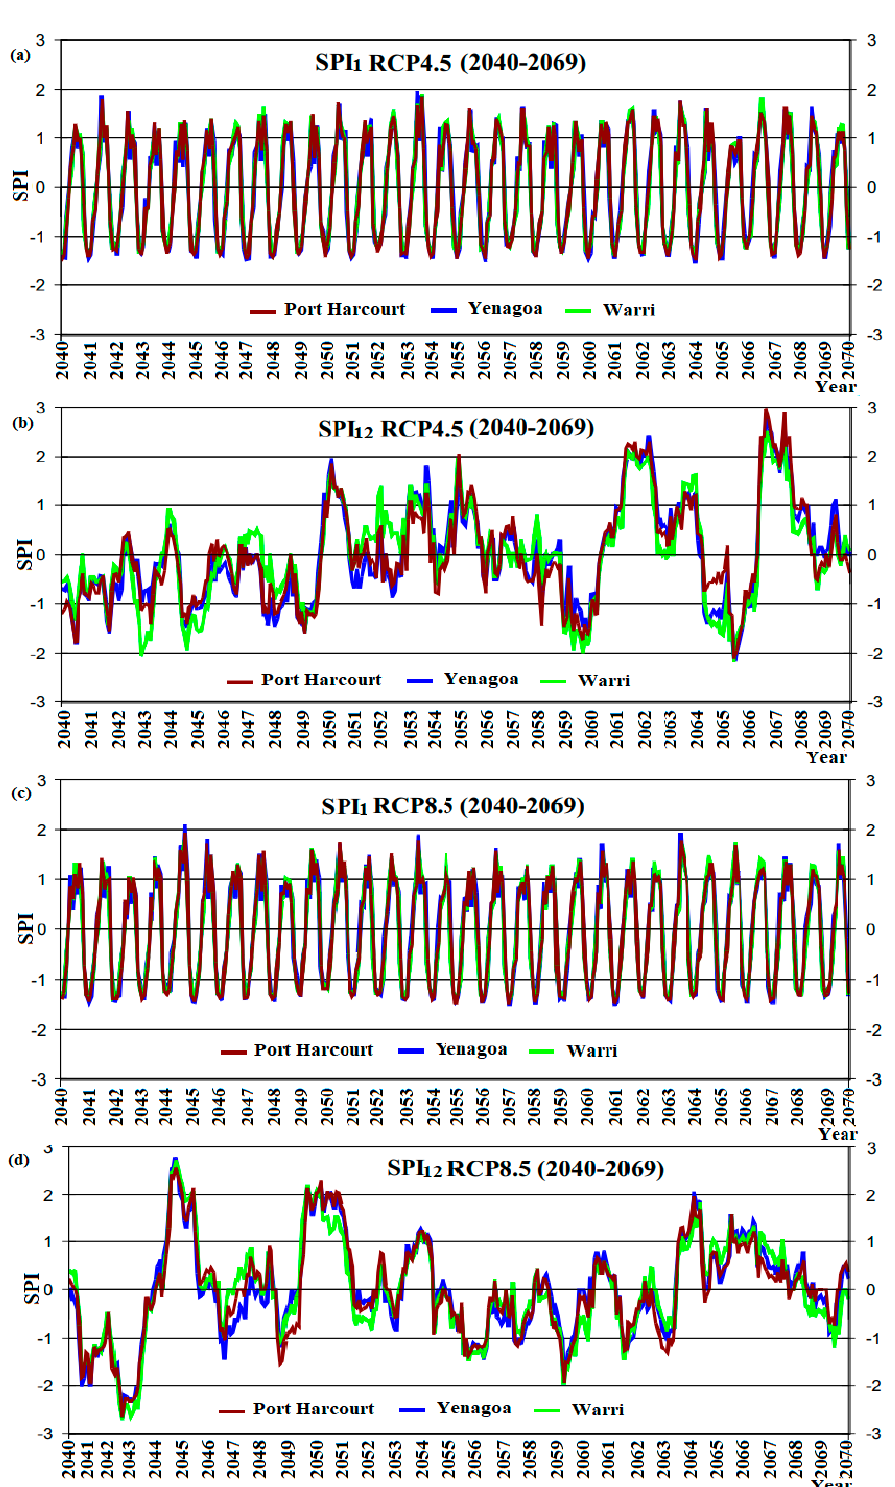
Figure 6. Computed ( a ) 1-month RCP4.5 SPI, ( b ) 12-month RCP4.5 SPI, ( c ) 1-month RCP8.5 SPI, and ( d ) 12-month RCP8.5 SPI for the projected periods from 2040 to 2069 across the study locations.